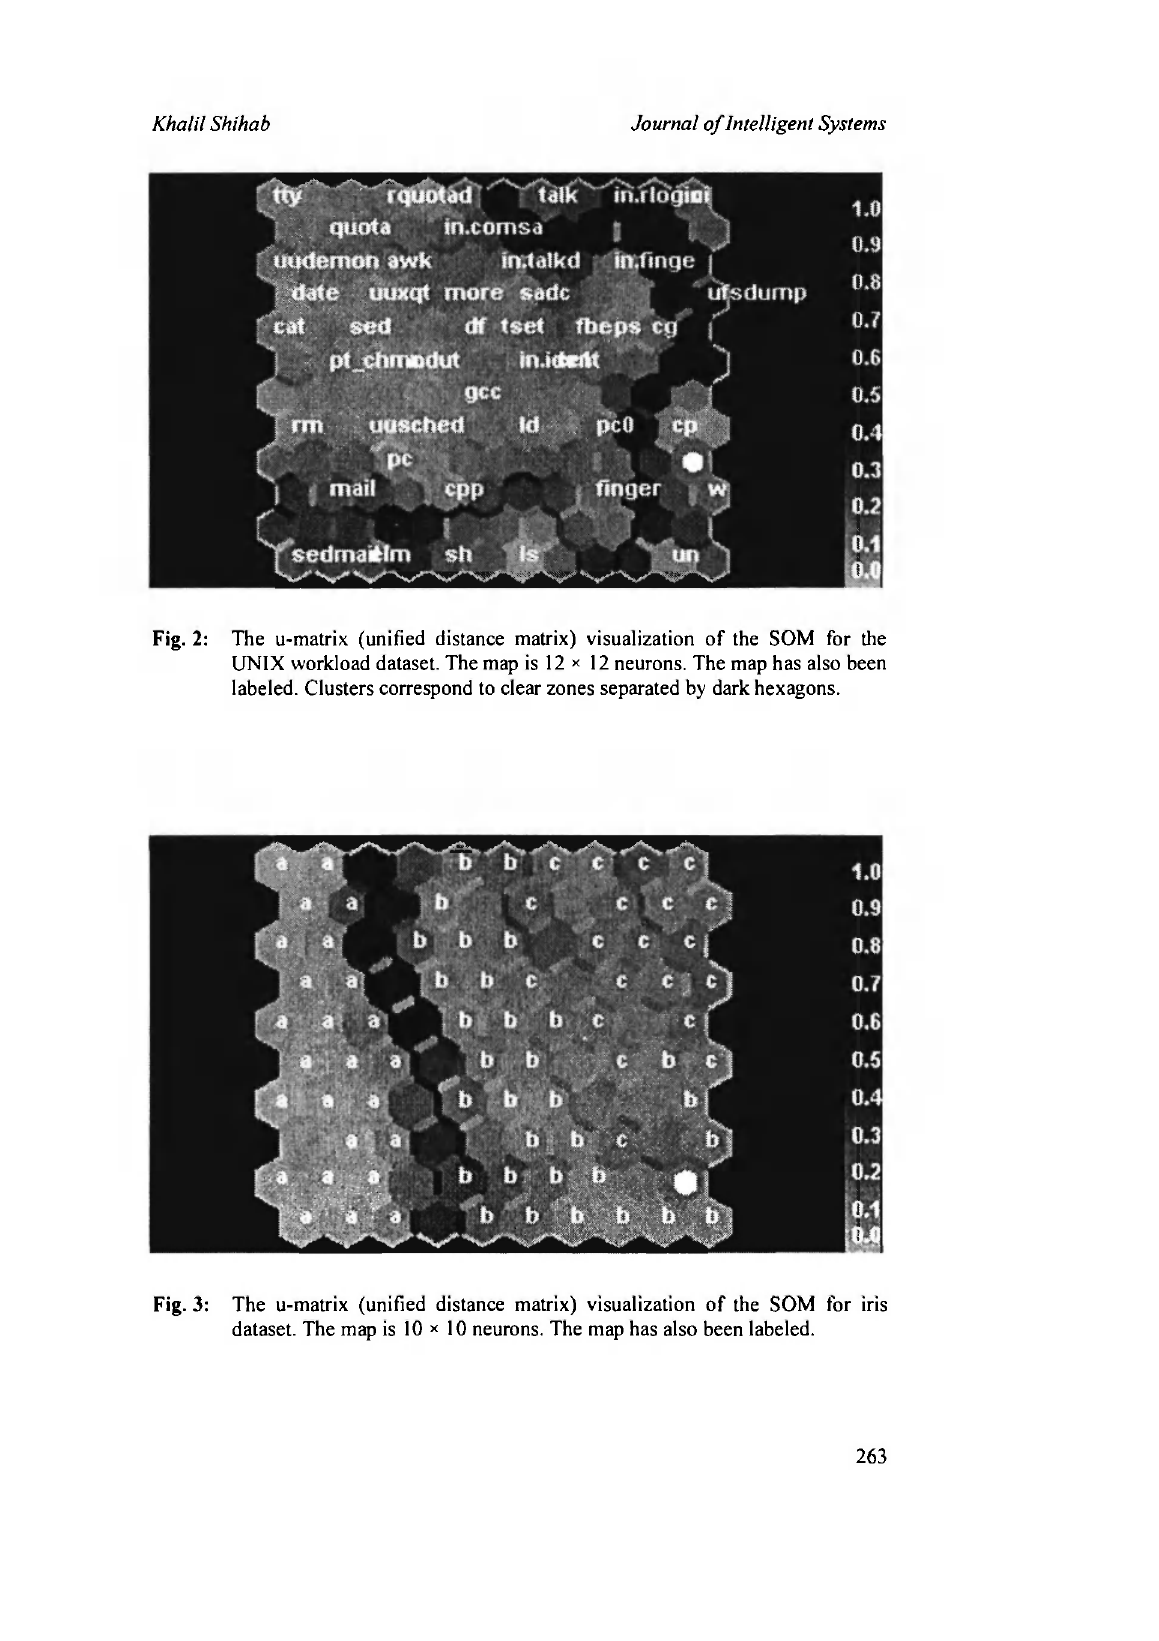
Fig. 2: The u-matrix (unified distance matrix) visualization of the SOM for the UNIX workload dataset. The map is 12 χ 12 neurons. The map has also been labeled. Clusters correspond to clear zones separated by dark hexagons.